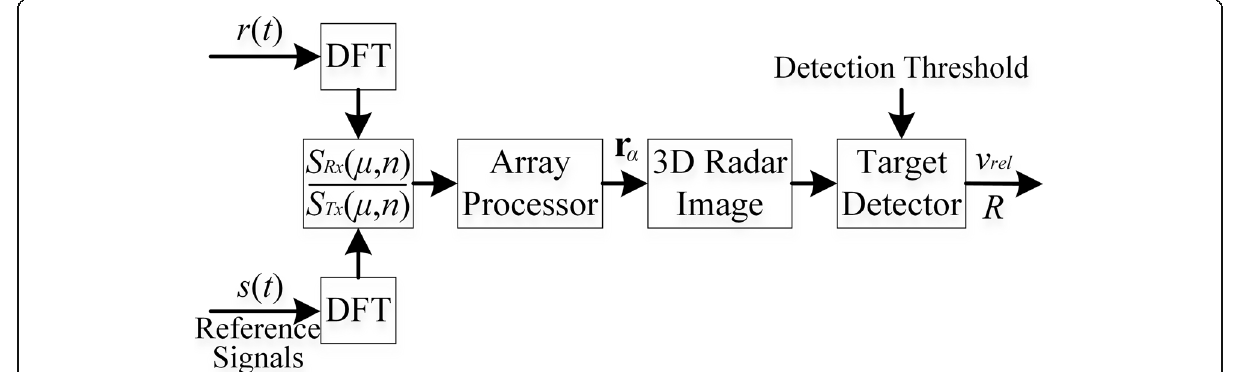
Fig. 10 Structure of frequency-domain detection processor